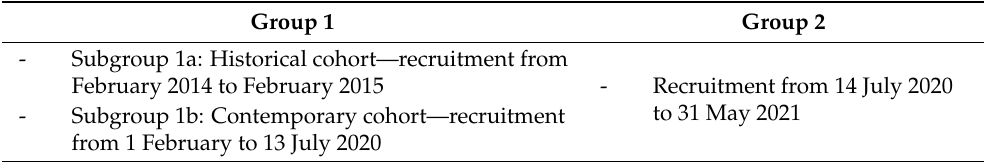
Table 1. Periods of recruitment of the infants fed either fortified HM based on its assumed macronu- trient content (Group 1) or fortified HM based on its measured macronutrient content (Group